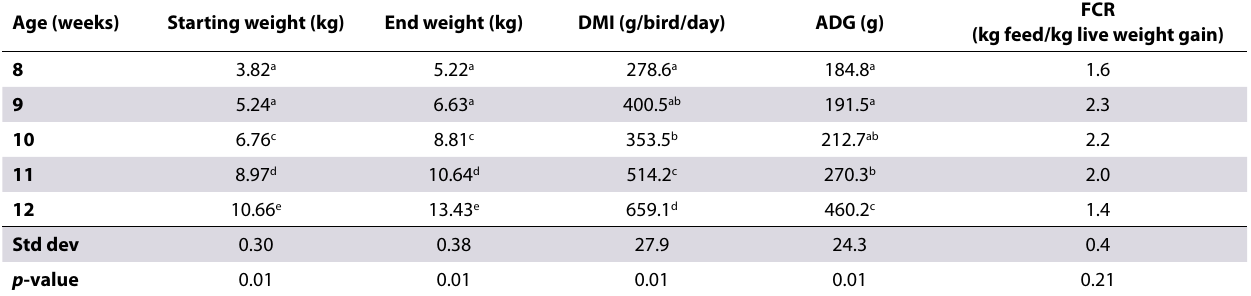
Table VI: The effect of age on production performance of ostrich chicks (7–12 weeks of age) Age